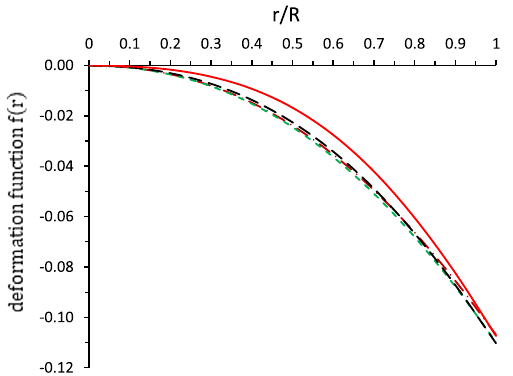
Fig. 1 The trend of decoupler function f ( r ) versus radial coordi- nate r / R . The different curves describe the following compact objects namely the red curve (solid) for 4U 1538-52, black curve (long-dashed) for SAX J1808.4-3658, green color (small-dashed) for SMC X-1, ver- milion color (dot-dashed) for LMC X-4. We have chosen D = 0 . 0022 and A = 0 . 0031 for plotting of these curves with different compactness as 0 . 1355, 0 . 1384, 0 . 15 and 0 . 1682 corresponding to compact objects 4U 1538-52, SAX J1808.4-3658, SMC X-1 and LMC X-4,